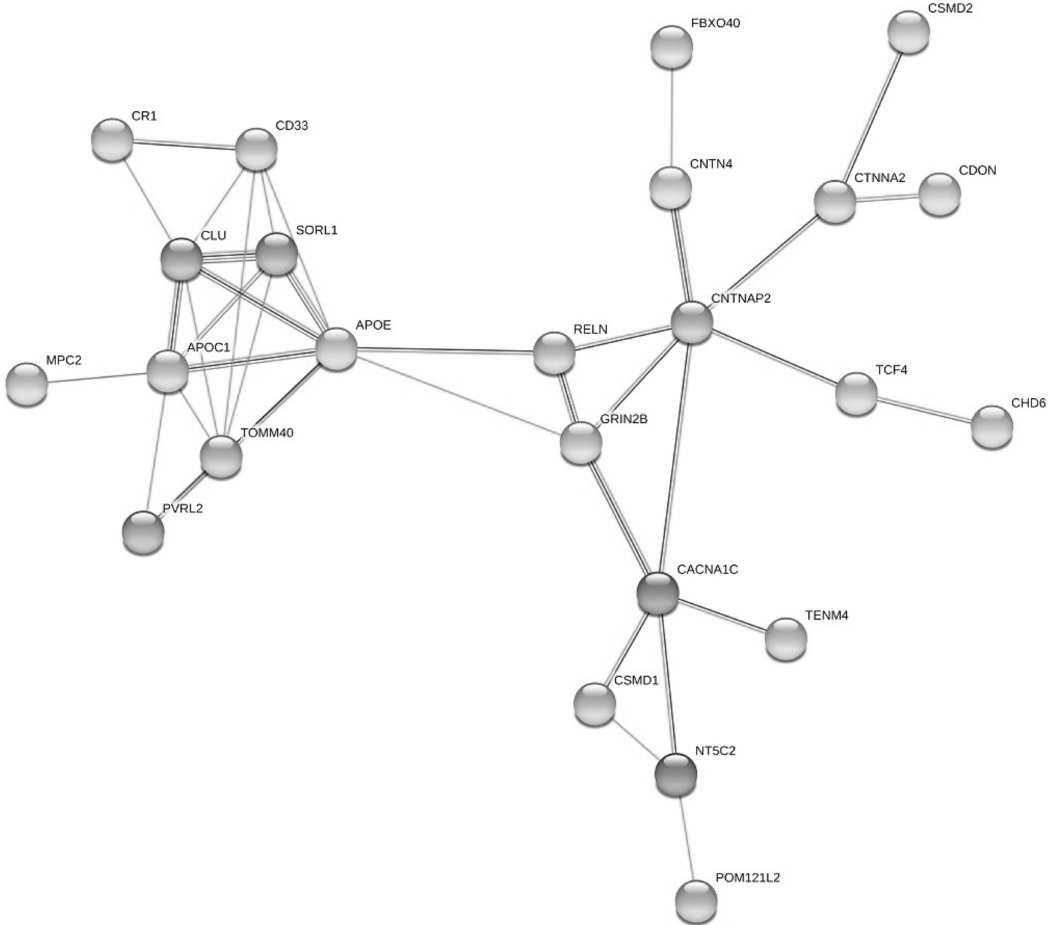
Figure 4. Protein–protein interaction network of studied genes. The nodes and edges represent the proteins (genes) and their interactions, respectively. The PPI network contained 24 nodes and 39 edges. The STRING indicated that the proteins formed three subnetworks of interconnected gene products. Each subnetwork had a central protein: APOE, CACNA1C, CTNNA2. All these three subsystems are connected together by RELN as a